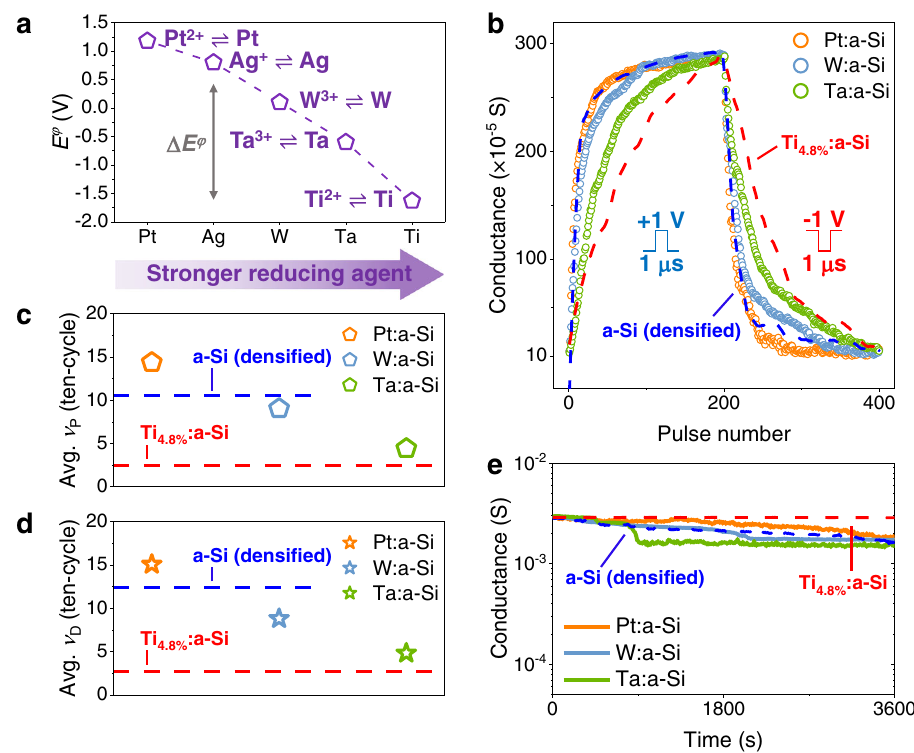
Fig. 4 Analogue switching performance of the M:a-Si memristors in various metal systems (M = Pt, W, and Ta). a Standard reduction potential of incorporated metals ( E φ values taken from ref. 30 ). b Analogue conductance update of the M:a-Si (M = Pt, W, and Ta) memristors under the 1/ − 1 V, 1 μ s pulse condition with 0.1 V, 1 μ s read pulse. The P/D switching under the same pulse condition of the a-Si (densi fi ed) (dashed blue line) and Ti 4.8% :a-Si (dashed red line) memristors are referenced. c Average potentiation and d depression nonlinearity factor of the M:a-Si (M = Pt, W, Ta, and Ti) memristors for ten-cycle under 1/ − 1 V, 1 μ s pulse condition. e Analogue data retention capability of the M:a-Si (M = Pt, W, and Ta) memristors, measured by 0.1 V read bias. The devices were programmed to the maximum conductance state ( G max ) under 1/ − 1 V, 1 μ s pulse condition before the retention test. The retention test of the a-Si (densi fi ed) and Ti 4.8% :a-Si memristors are